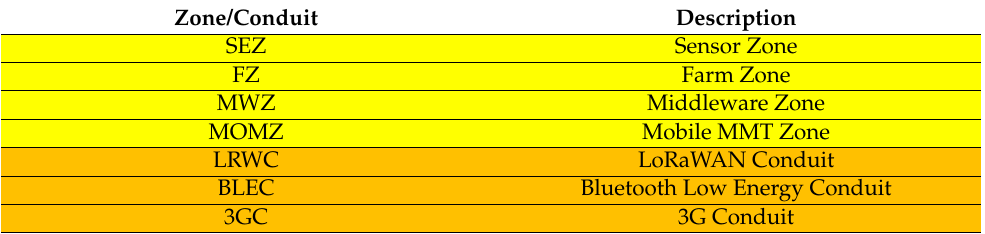
Table 22. Sub-SuC: Zone/Conduit Overview.